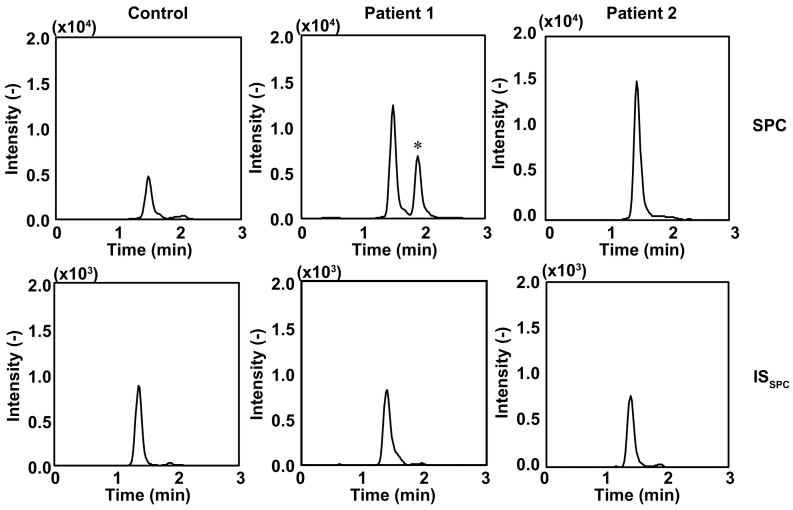
Representative chromatograms for SPC and ISSPC from NPC-affected and control individuals. The concentration of SPC and ISSPC was quantified using LC-MS/MS with MRM mode (SPC, 465.55 > 183.95; ISSPC, 451.4 > 183.90) as described in the experimental procedures. Both SPC and ISSPC were detected as [M + H]+ ion using ESI positive mode. * denotes an uncharacterized peak.